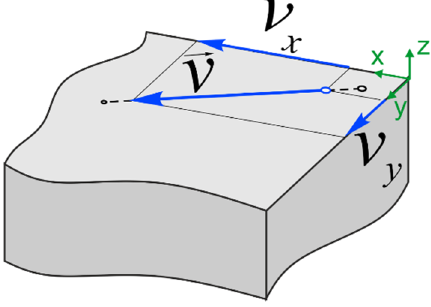
Figure 1. Cladding speed vector projection on the x- and y- axes. The solution for a moving point source can be obtained by taking the integral over the source action time t (cid:48) from t 1 to t 2 (the source started acting at time t 1 and finished acting at time t 2